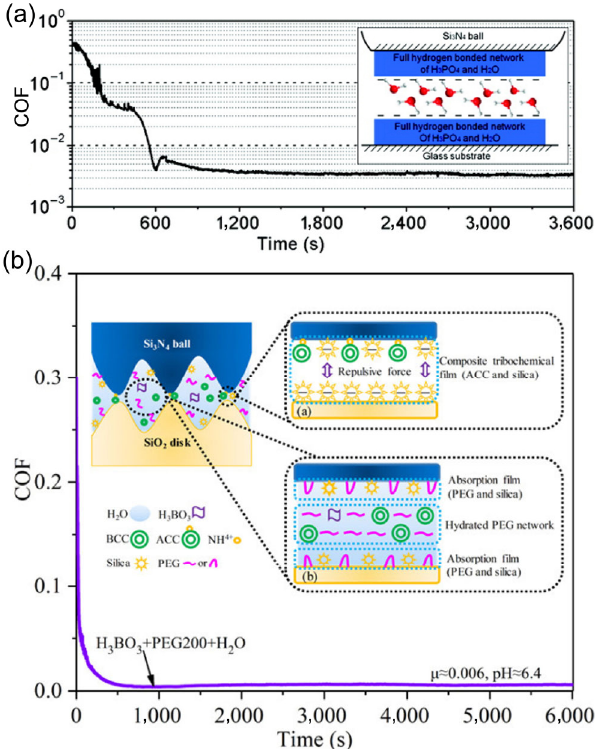
Fig. 4 (a) Superlubricity of phosphoric acid. The hydrogen-bond network can further induce the formation of a layer of hydrated water. Reproduced with permission from Ref. [43]. © American Chemical Society, 2011. (b) Superlubricity obtained under a neutral condition in the mixture of boric acid and PEG. Reproduced with permission from Ref. [51]. © American Chemical Society, 2018.